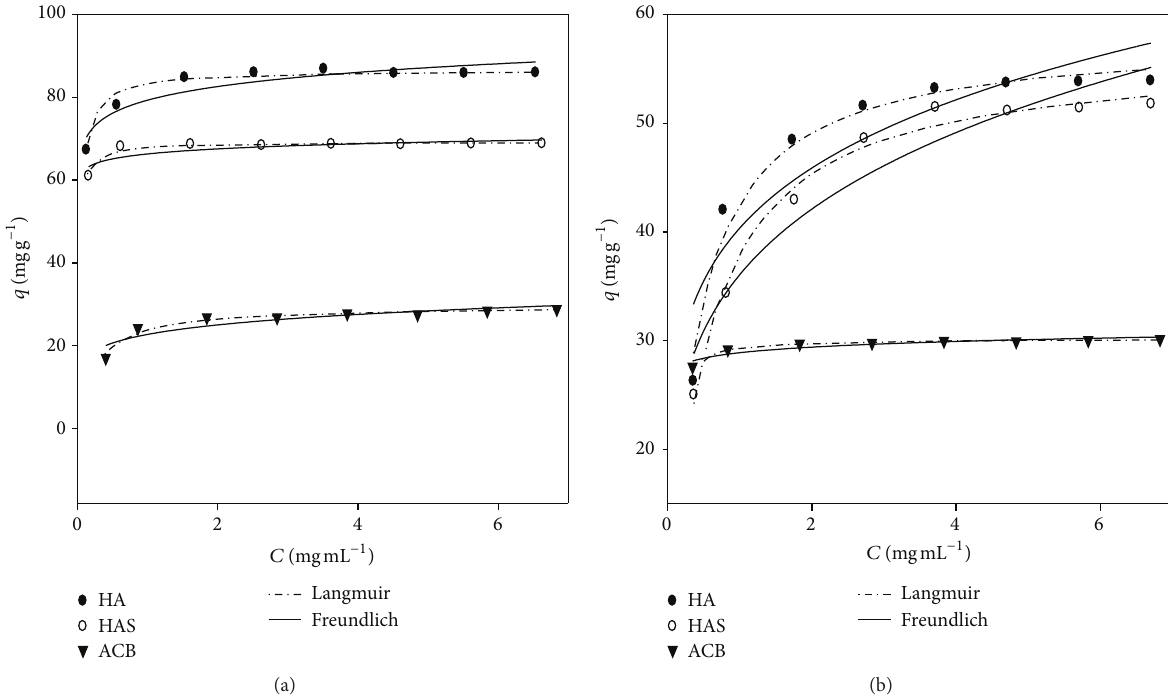
Figure 4: BSA adsorption isotherms on hydroxyapatite (HA), synthetic hydroxyapatite (HAS), and active babassu coal (ACB) at pH 4.0 (a) and 7.0 (b) at 25 ∘ C for adjustment of the Langmuir and Freundlich models. The symbols represent experimental